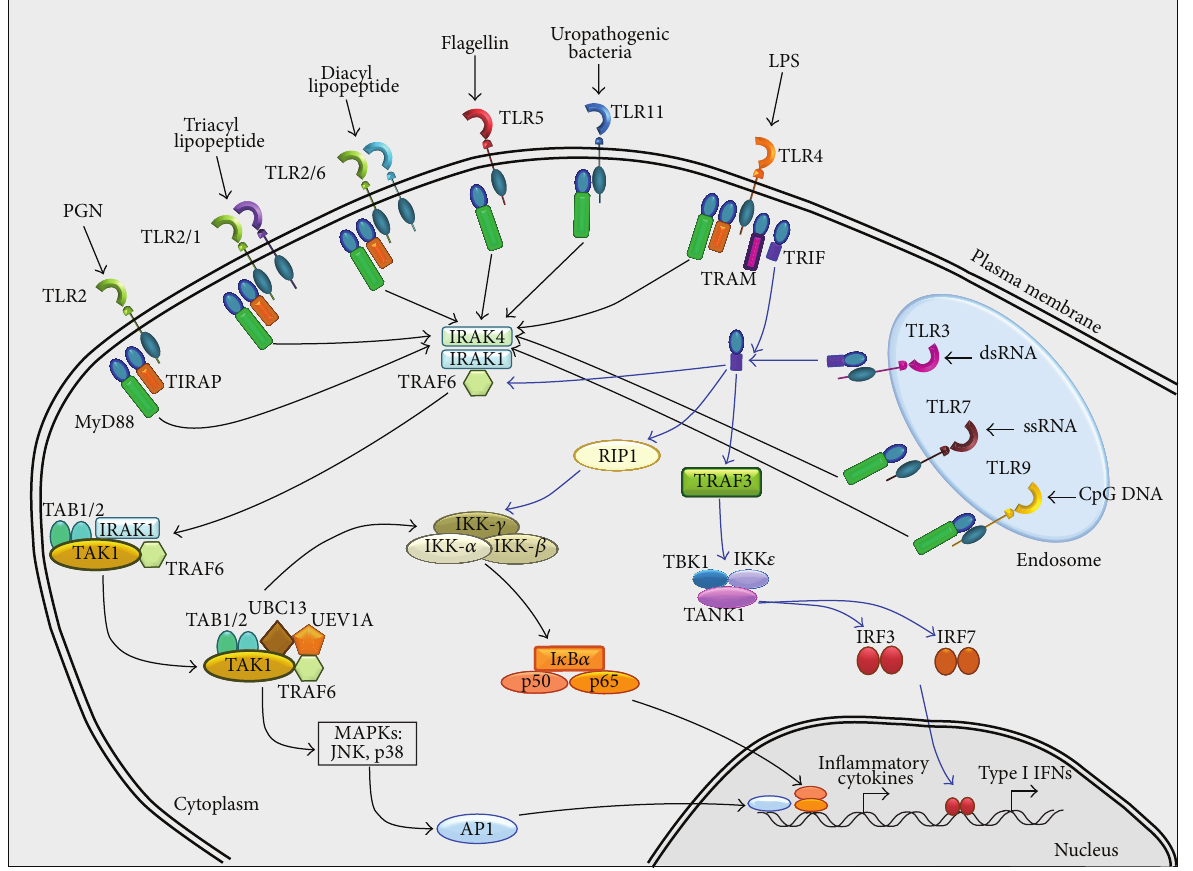
Figure1: TLRssignaling .TLRsignalingisactivatedinaMyD88-dependent( blackarrows )andTRIF-dependent( bluearrows )manner.MyD88 signaling leads to NF- 𝜅 B activation, while TRIF signaling leads to both IRF3 and NF- 𝜅 B activation. In the MyD88-dependent ubiquitination of TRAF6 is important to activate MAPKs (JNK, p38 and ERK) or IKK complex to induce the translocation of NF- 𝜅 B to the nucleus. The TRIF-dependent signaling pathway can activate NF- 𝜅 B, IRF3, and